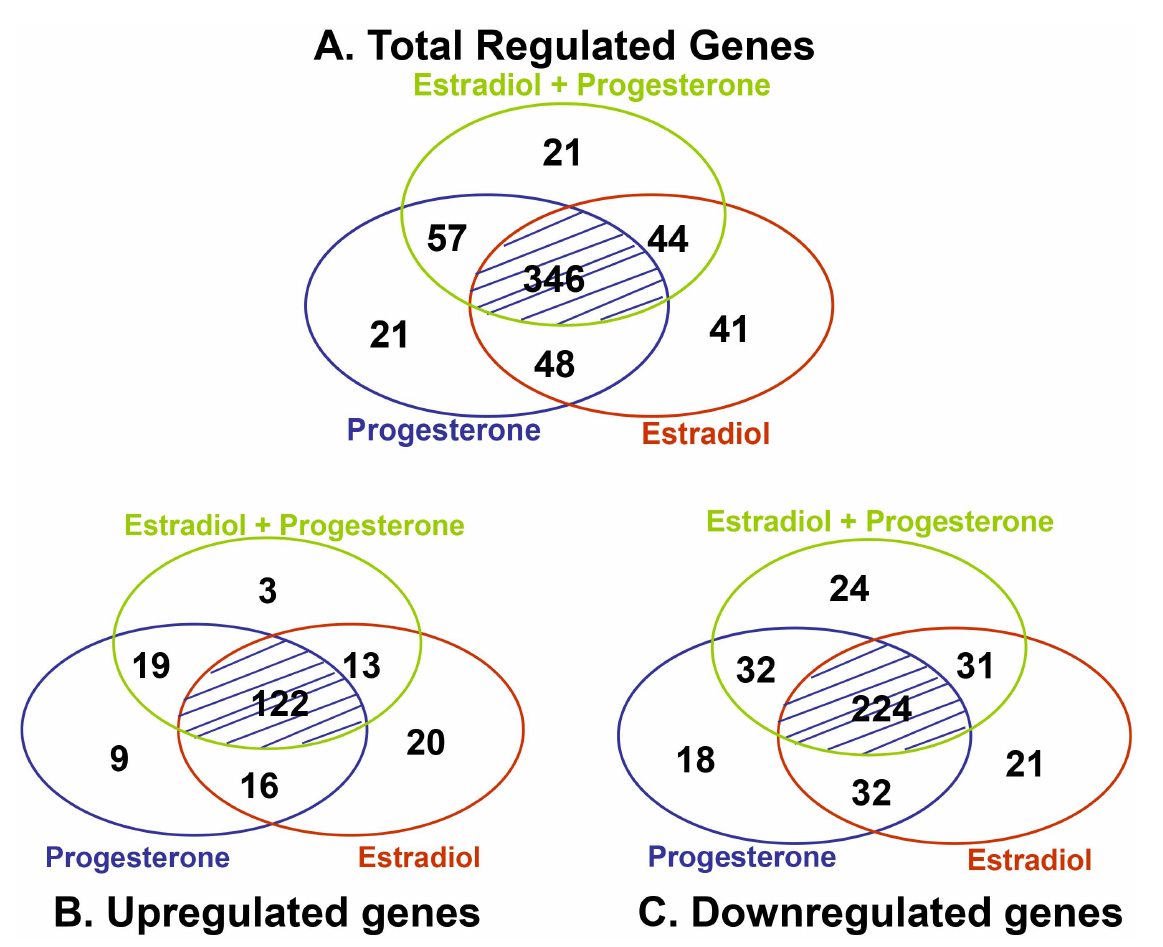
Figure 5. Venn diagrams. Venn diagrams of all genes regulated by estradiol-17 b (E2T), progesterone (P4T) and the combined treatment (E2P4T) (A); genes up-regulated (B) and down-regulated (C) by all treatments; the highlighted intersection represents genes that were commonly regulated by all treatments. Each of the circles represents a different treatment. The numbers in the intersection of the circles represent the number of transcripts that were affected in the treatments represented by those respective circles. The numbers in the outer portion of each circle represent the number of transcripts that were exclusively affected in the treatment represented by that particular circle. There was a total of 578 differentially expressed genes (A); 202 upregulated genes (B) and 382 downregulated genes (C) compared to controls, considering the following stringency: fold change . 1.25 and P , 0.05.